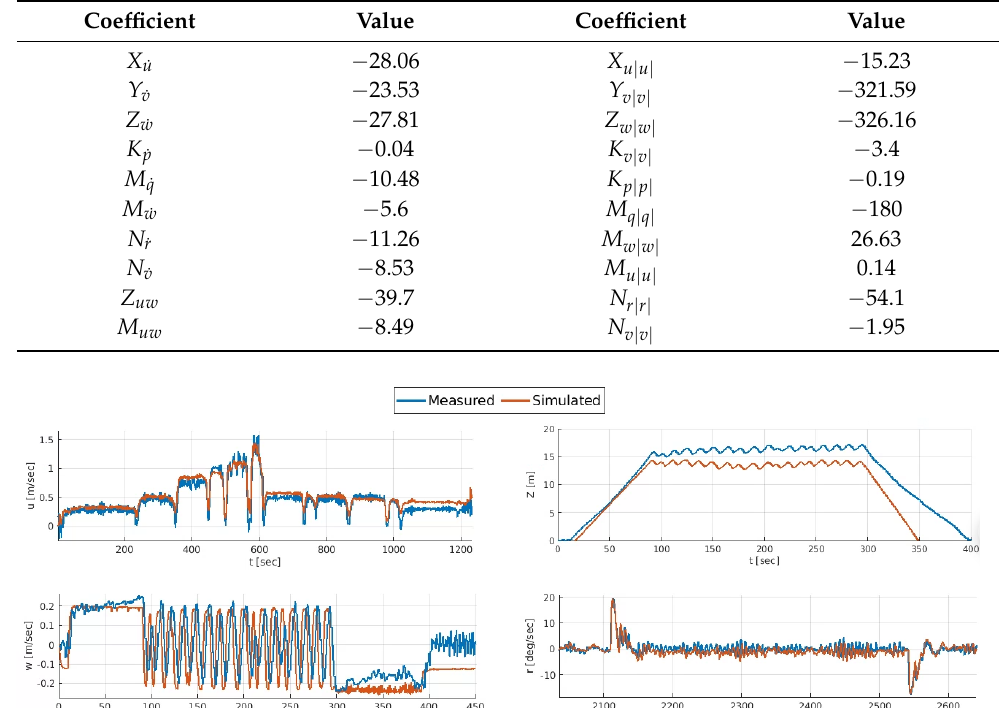
Table 1. ALICE hydrodynamic coefficients.